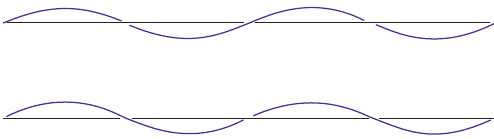
Figure 4.1 . The right-hand screw helix ( bottom ) and the left-hand screw helix ( top ) in relation to the x -axis. The xz projection of ( 4.1 ) or ( 13.1 ) is